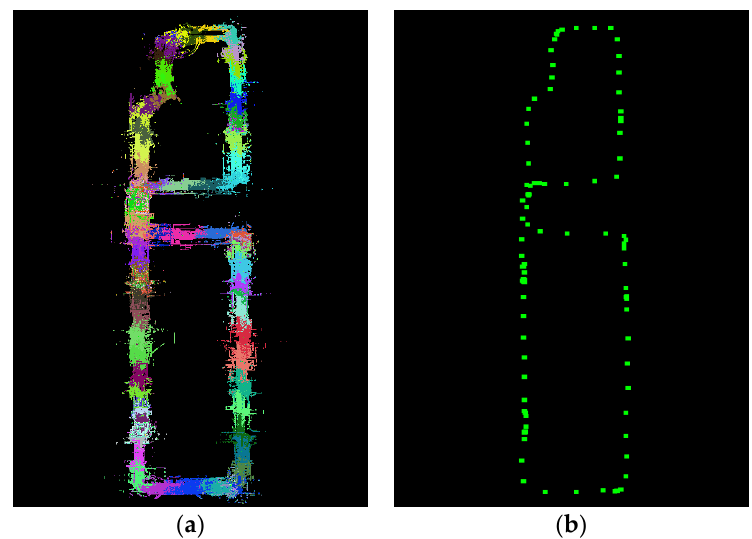
Figure 5. Example of kinematic point cloud slicing (5 s interval): ( a ) Top view of the kinematic point cloud with colors indicating the point clouds for each temporal slice; ( b ) Time slice trajectory centroids used for subsequent plotting.